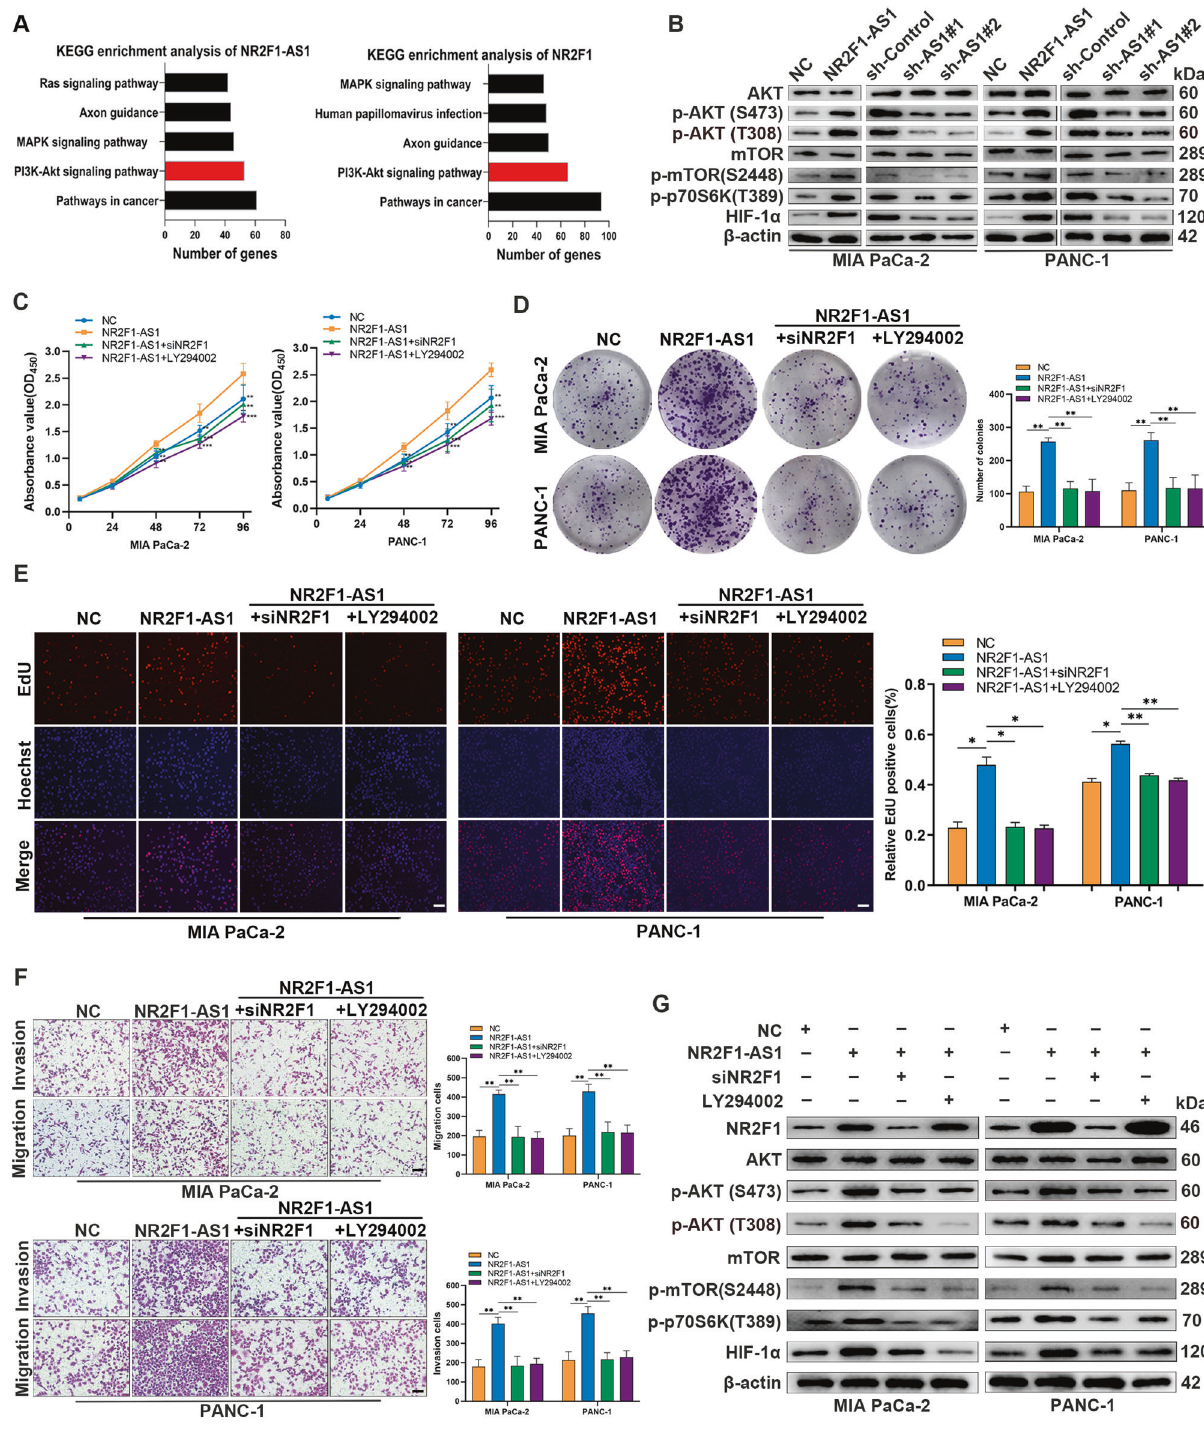
Fig. 6 NR2F1-AS1/NR2F1 activates the AKT/mTOR pathway in PC cells. A The pathway analysis of NR2F1-AS1 with co-expressed genes using COEXPREdb (http://coxpresdb.jp/) by the KEGG. B Western blot analysis of AKT, p-AKT, mTOR, p-mTOR, p70 S6K, and HIF-1 α in the indicated PC cells. C CCK-8 assays in the NC, NR2F1-AS1, NR2F1-AS1 + siNR2F1, and NR2F1-AS1 + LY294002 groups of PANC-1 and MIA PaCa-2 cells. D Colony-formation assays in the indicated PC cells. E EdU assays in the indicated PC cells. F Transwell assays showing the migration and invasion abilities of the indicated PC cells. G Western blot analysis of NR2F1, AKT, p-AKT, mTOR, p-mTOR, p70 S6K, and HIF-1 α in the indicated PC cells. Scale bar = 200 μ m. Data are expressed as mean ± SD. All experiments were repeated three times independently. * P < 0.05, ** P < 0.01, *** P <